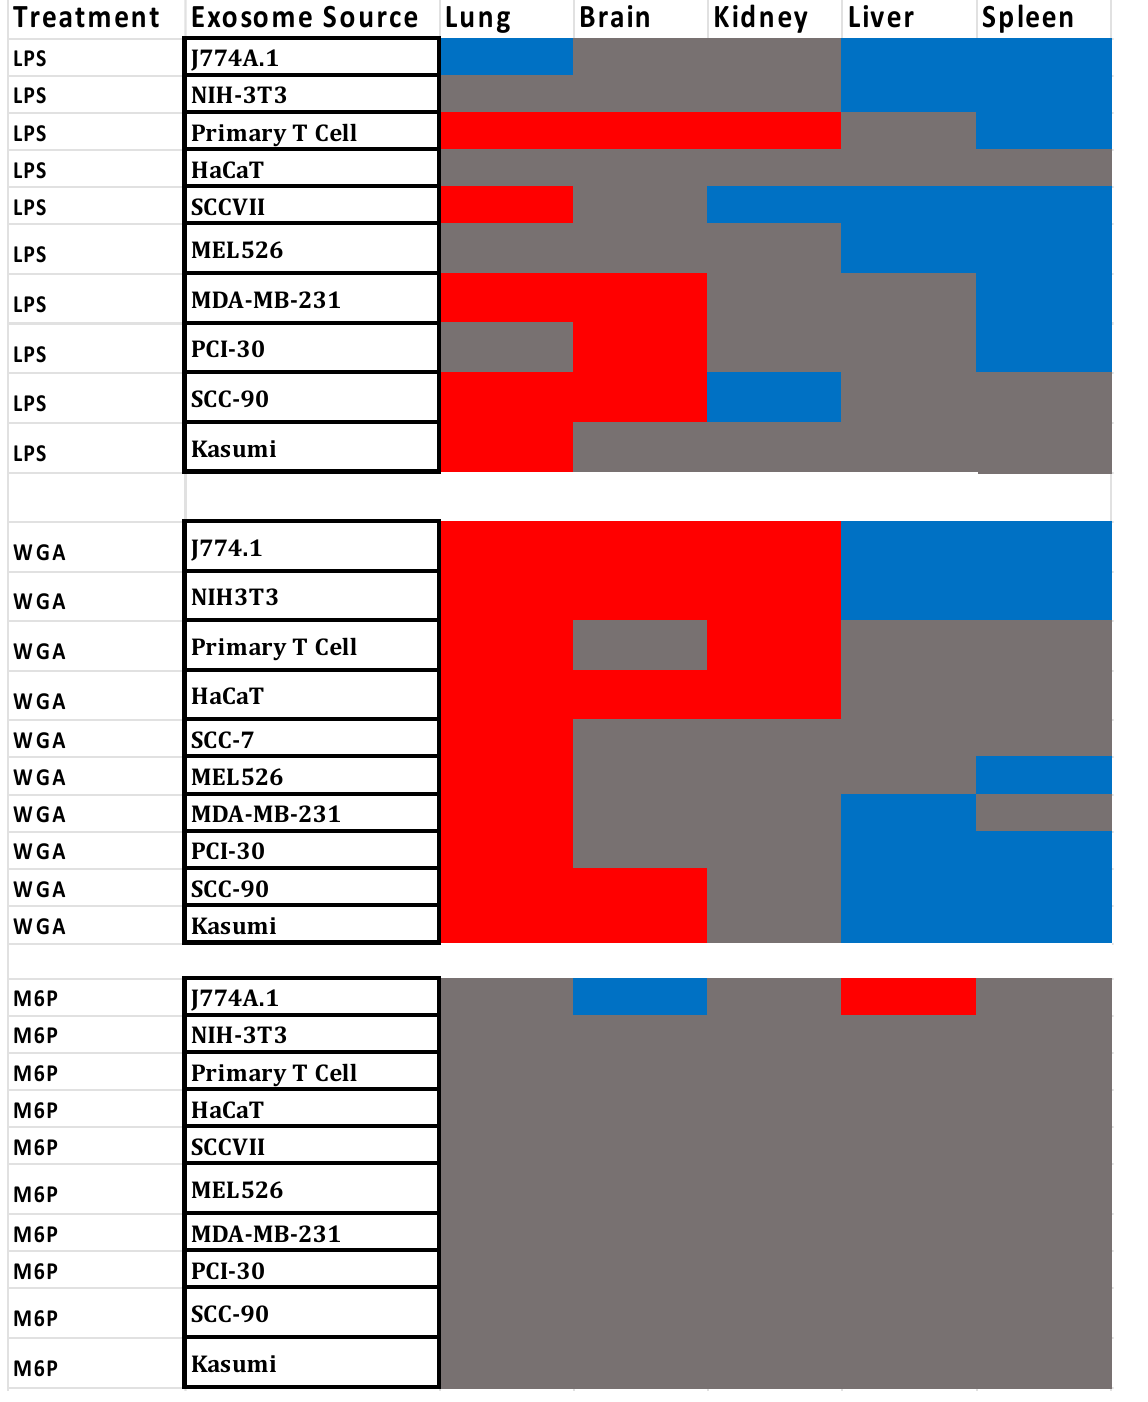
Figure 8. Heat map correlating changes in exosome sequestration following LPS, WGA or M6P treatments. Blue color indicates that LPS, WGA, or M6P induced a statistically significant decrease in sequestration of the exosomes, and red color indicates that LPS, WGA, or M6P induced a significant increase in sequestration of the exosomes. Grey indicates that LPS, WGA, or M6P did not produce a statistically significant alteration in the exosome sequestration. Liver-spleen show strong similarities to one another, whereas lung, brain, and kidney form another group.